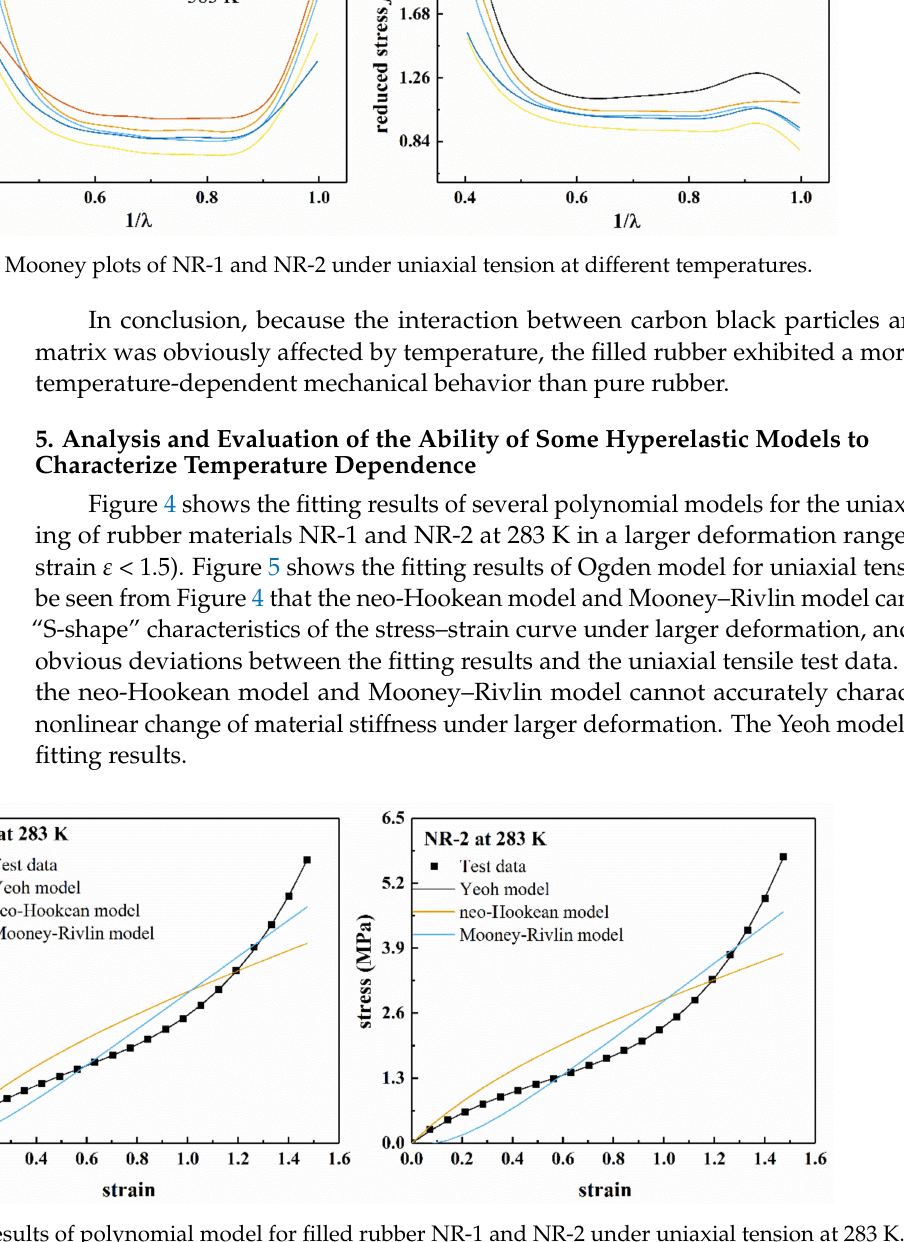
Figure 4. Fitting results of polynomial model for filled rubber NR-1 and NR-2 under uniaxial tension at 283